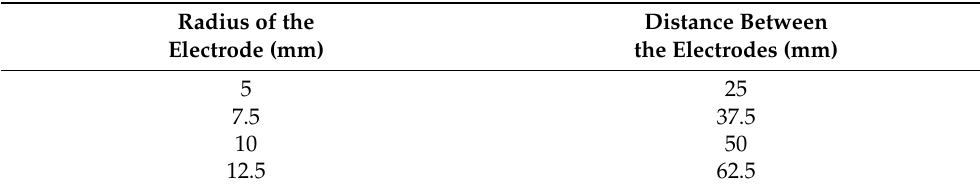
Table 2. Specifications of the experiments.